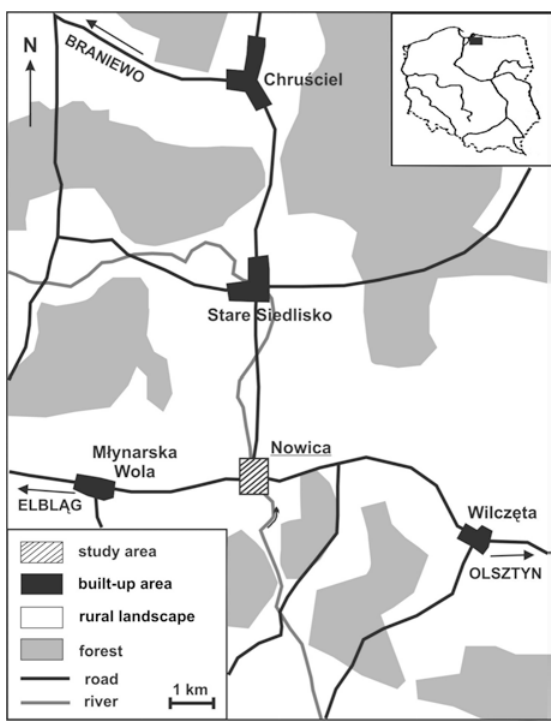
Fig. 1. Location of the investi- gated